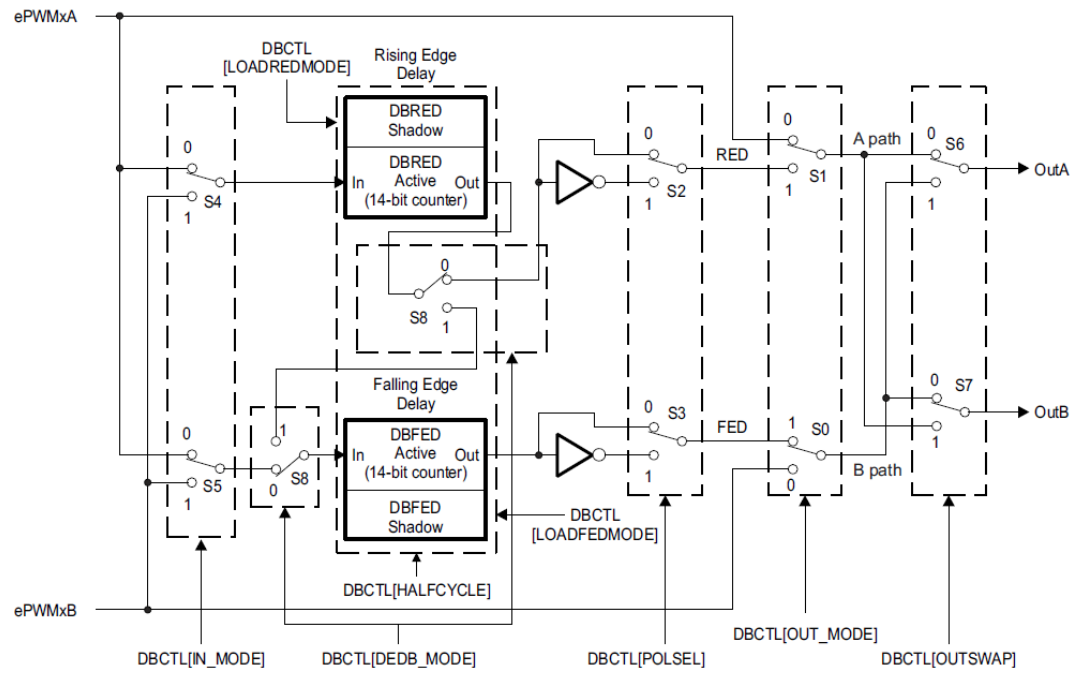
Figure 8. Enhanced Pulse Width Modulation (ePWM) dead band submodule